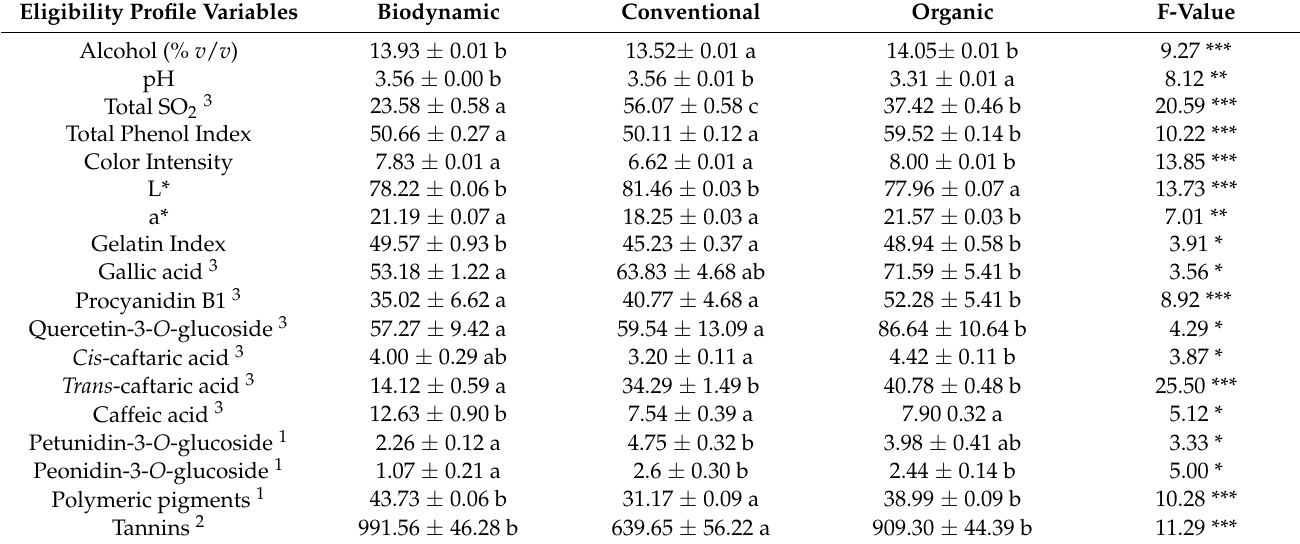
Table 4. ANOVA table of the significant eligibility and identity profile variables of Chianti 2016. Data are expressed as mean of three determinations; in each row, different letters (a–c) indicate statistically significant differences. F-values and significance, and standard deviation are also